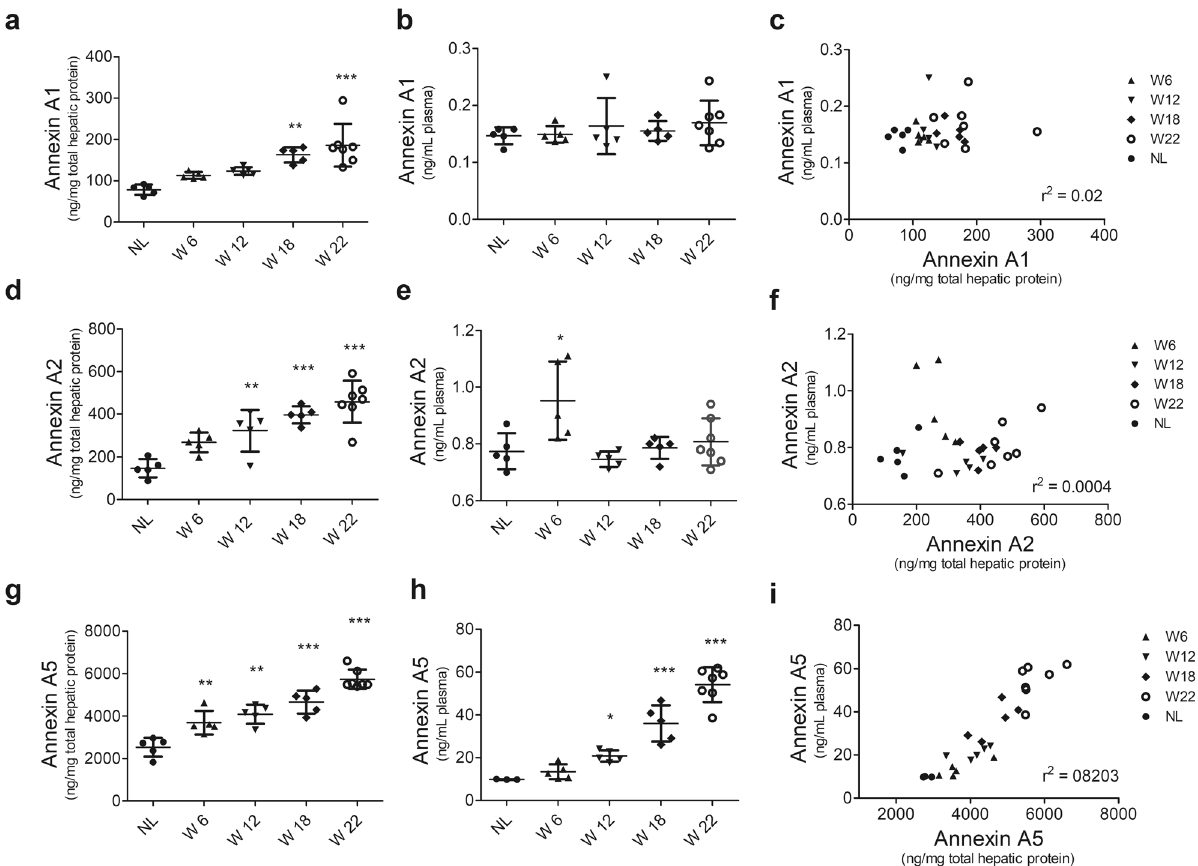
Figure 5. Liver and plasma annexin levels and their correlation during HCC progression. Determination of annexin levels by ELISA in liver tissues ( a , d , g ) or plasma samples ( b , e , h ). Correlation between the levels of annexin proteins in liver tissues and plasma samples ( c , f , i ). Data represent the mean ± SD. p values were calculated by the ANOVA test. n = 5 animals/group. NL normal liver, W week. *** p < 0.001; ** p < 0.01; * p <